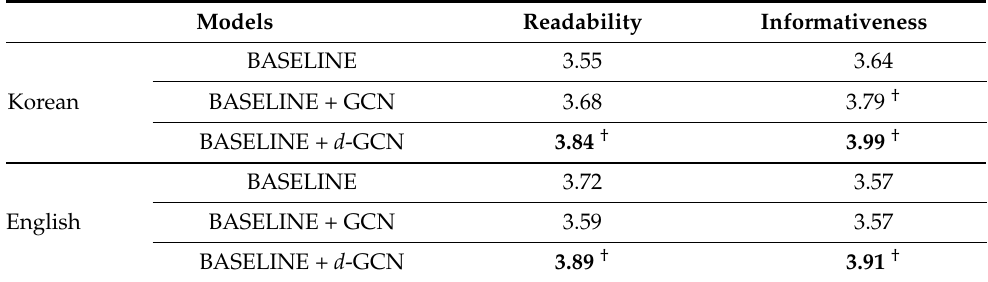
Table 4. Results of human evaluation of Korean and English sentence compression. † indicates that the difference of the score from the BASELINE is statistically significant with 0.95 confidence. We used the same method as in Tables 2 and 3 with 100,000 random samples.